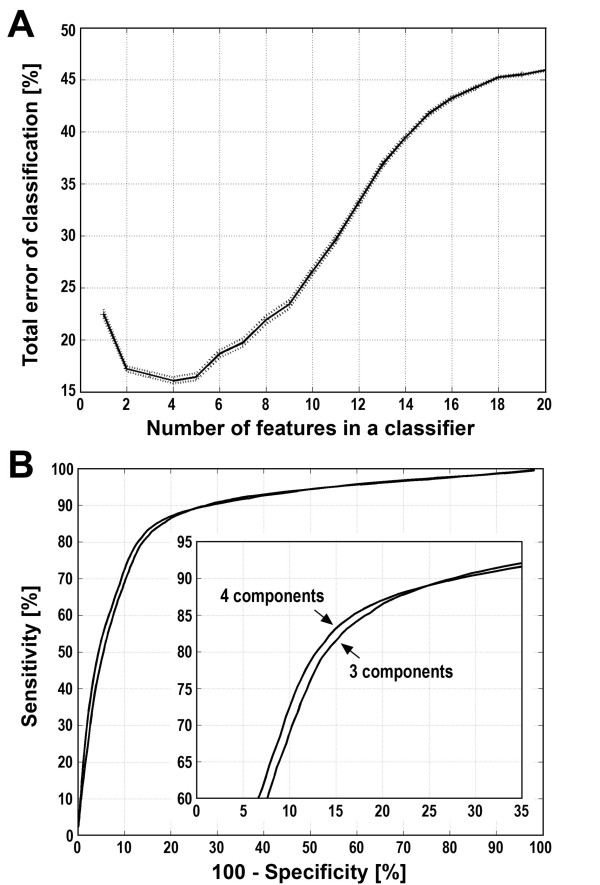
Estimation of the performance of classification of breast cancer samples. A – The total error rate was plotted against the number of features (i.e. spectral components) in the classifier. Shown are average error rates and 95% confidence intervals calculated based on 1000 random validation experiments with 50:50 training/validation split of data. B – Estimation of the sensitivity and specificity of the classification for classifiers built of three or four spectral components. The ROC curve was computed by changing the value of the probability threshold in the SVM classifier from 0.0 to 1.0, and averaging the specificity obtained versus sensitivity rate over 1000 random repeats of training and validation.